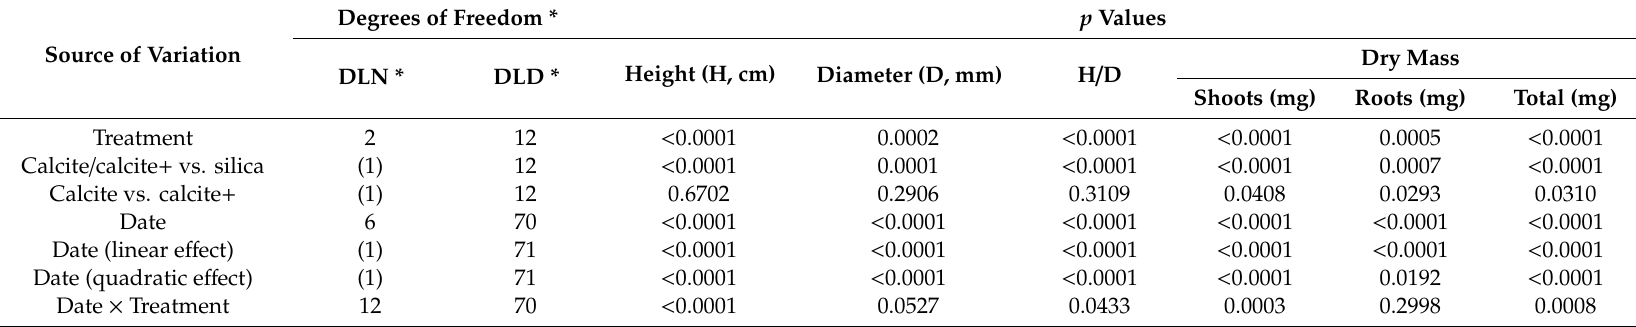
Table 2. Observed probabilities ( p -values) and degrees of freedom of the fixed e ff ects associated with the analysis of the variance of the growth variables of white spruce (2 + 0) seedlings under forest nursery conditions. A value of p in bold indicates a significant e ff ect at p < 0.05 of the Date × Treatment interaction, a Treatment e ff ect or a Date e ff